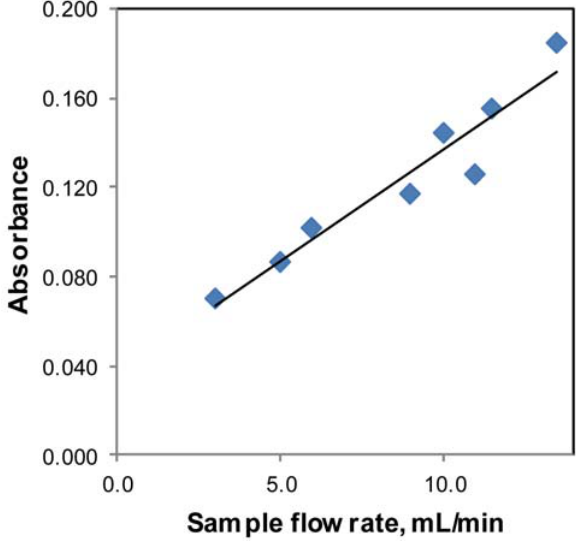
Figure 3. The effect of the flow rate of the sample solution on ab- sorbance. Sample volume was 10 mL, Cr(VI) concentration was 1